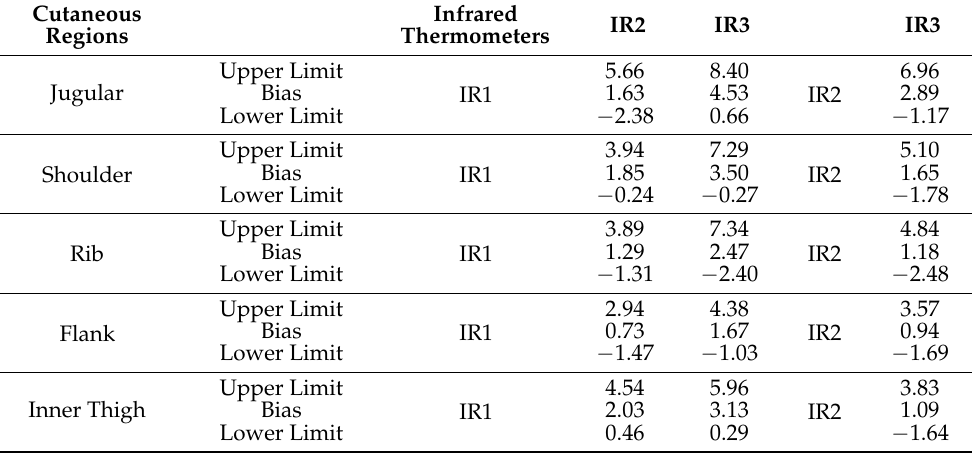
Figure 2. Bland–Altman comparisons of the rectal temperature values recorded with a digital thermometer, with the cutaneous temperature recorded using the three different non-contact infrared thermometers (IR1, IR2, and IR3) on the different cutaneous sites (jugular, shoulder, rib, flank, and inner thigh) in twenty healthy cats. The dotted lines represent the lower (L) and upper (U) limits of agreement (LOA); the solid line represents the mean difference (bias: B rectal temperature—cutaneous temperature) between the cutaneous and the rectal temperature measurements. Table 3. Bland–Altman comparisons of the cutaneous temperature recorded (the jugular, shoulder, rib, flank, and inner thigh) with three different non-contact infrared thermometers (IR1, IR2, and IR3) in twenty healthy